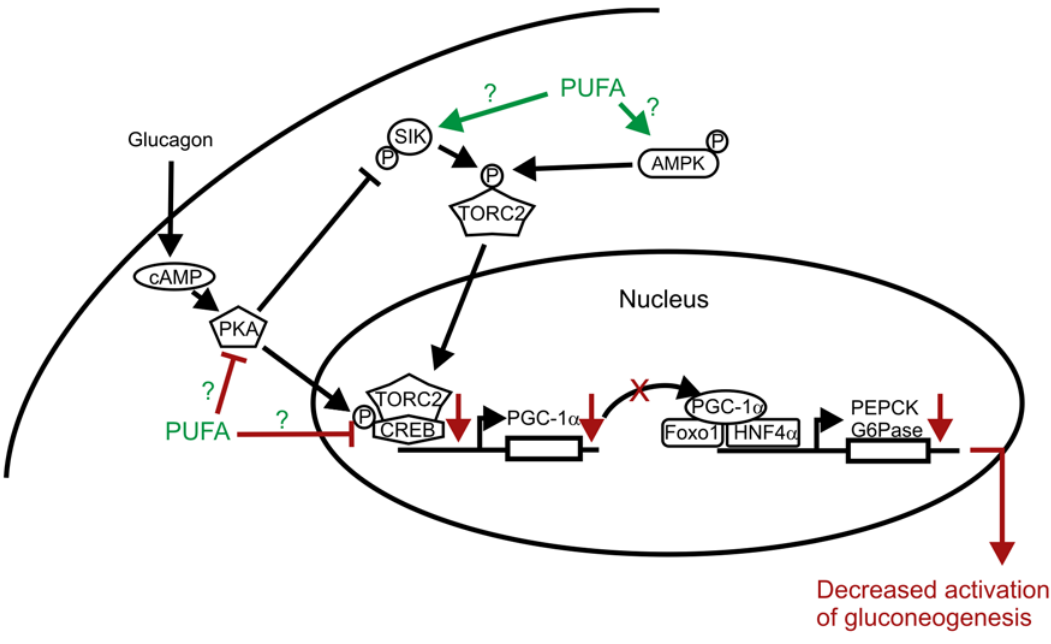
Figure 11. PUFA and activation of gluconeogenesis. Simplified schematic presentation of the identified kinase cascades regulating gluconeogenesis. The activation cascade leads to phosphorylation of CREB (cAMP-responsive element binding protein), which, together with TORC2 (transducer of regulated CREB activity 2), drives the expression of coactivator PGC-1 a . Transcription of the key gluconeogenic enzymes PEPCK (phosphoenoylpyruvate carboxykinase) and G6Pase (glucose-6-phosphatase) is induced when PGC-1 a associates with HNF4 a (hepatic nuclear factor 4 a ) and FOXO1 (forkhead box transcription factor). Nuclear translocation of TORC2, which is needed for activation of the gluconeogenic program, is controlled by phosphorylation by activated AMPK (AMP–activated protein kinase) and SIK (salt-inducible kinase). Observed changes in Decr 2 / 2 mice are indicated with red arrows. Possible targets of accumulated PUFA or their derivatives are also indicated.